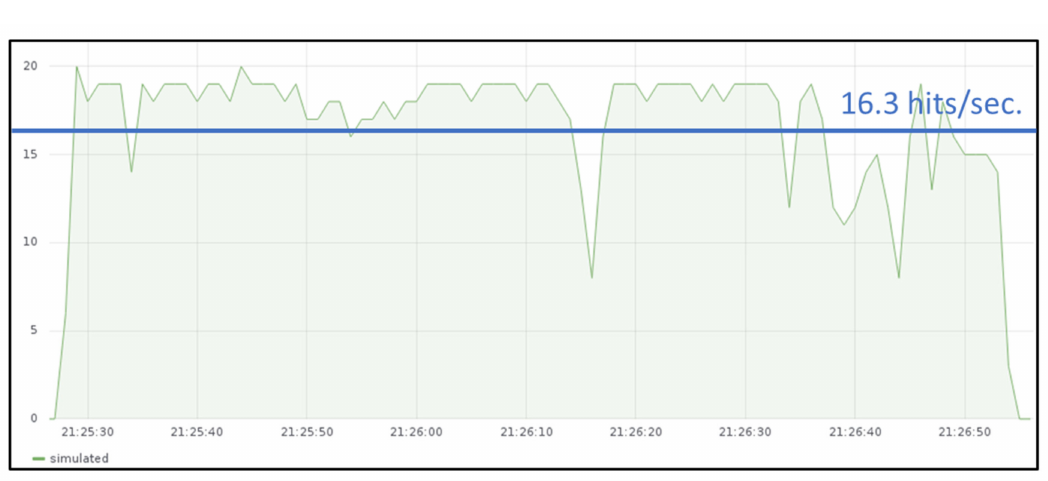
Figure 11. Throughput measured at IoT server when gateway is deployed in GKE